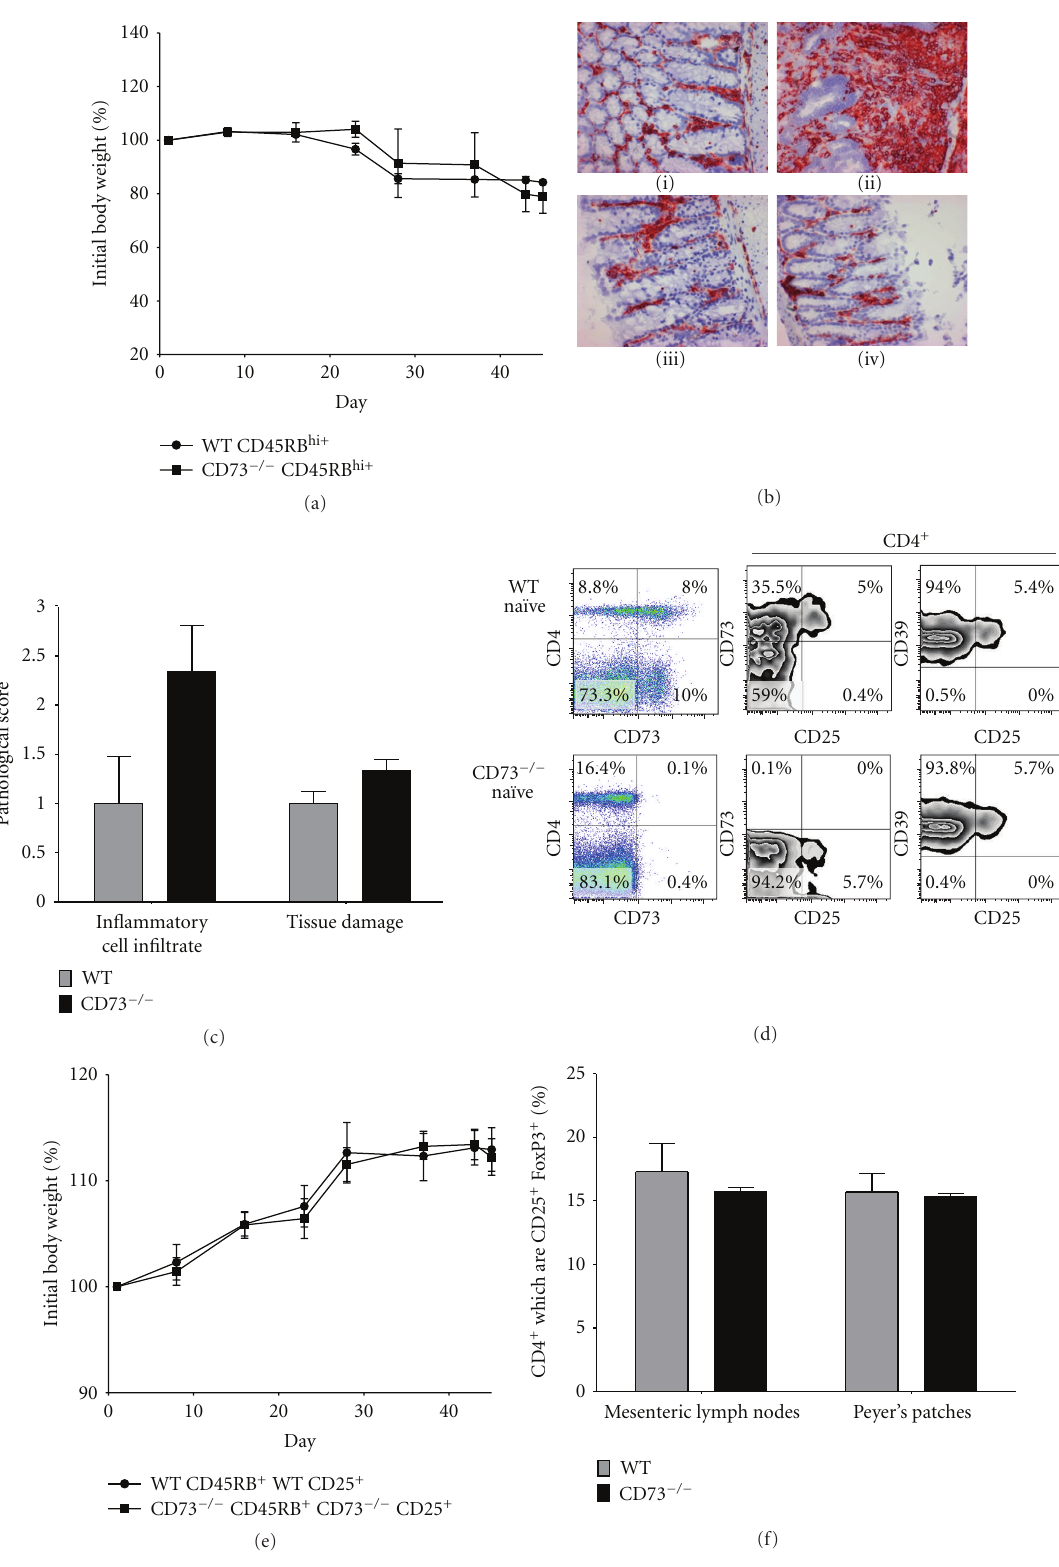
Figure 3: CD4 + T cells from CD73 − / − mice transfer a similar degree of colitis compared to WT mice and show no defect in T reg suppression of